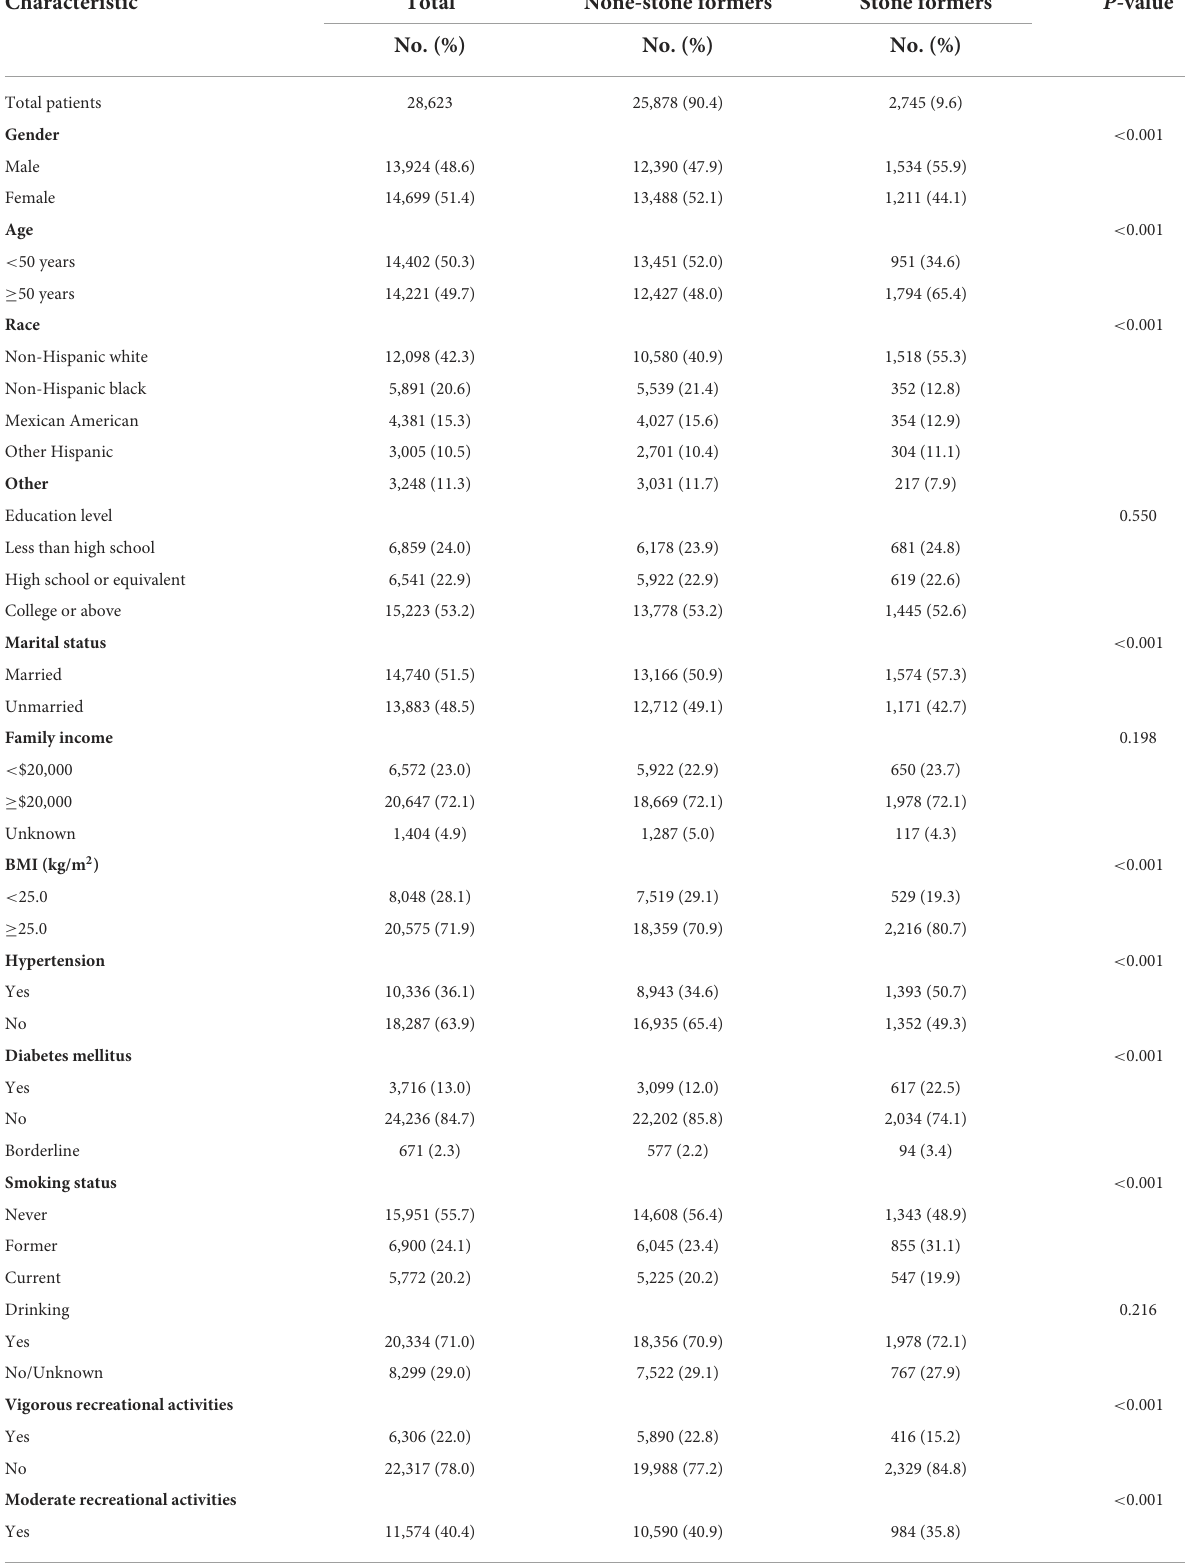
TABLE 1 Baseline characteristics of NHANES participants between 2007 and